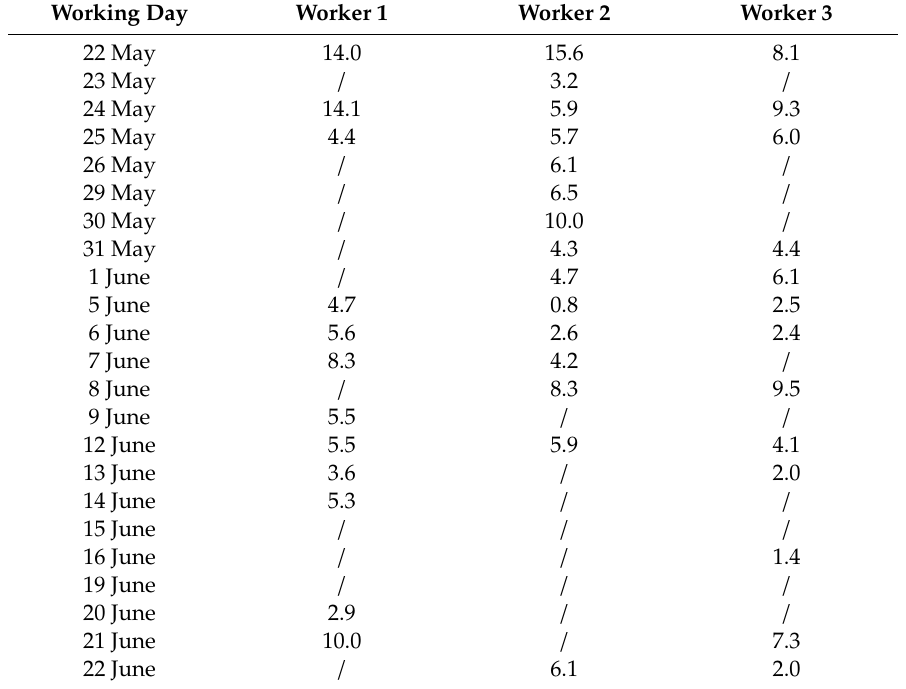
Table 2. Individual (40 daily measurements) occupational solar UVR exposure measured for three construction workers in Tuscany during 23 working days (22 May–22 June 2017) in standard erythemal doses per day (SEDs / day).